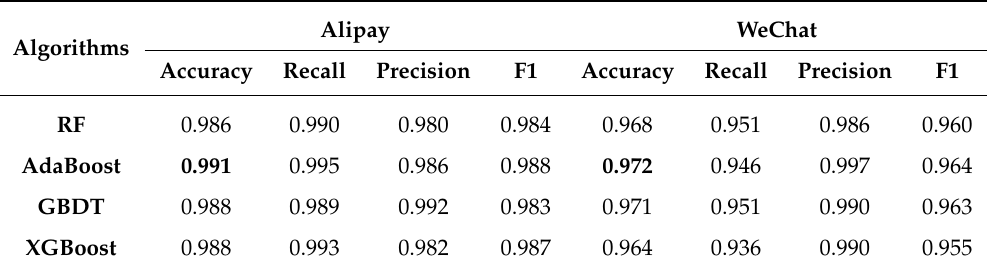
Table 4. Results on the Alipay app and the WeChat app